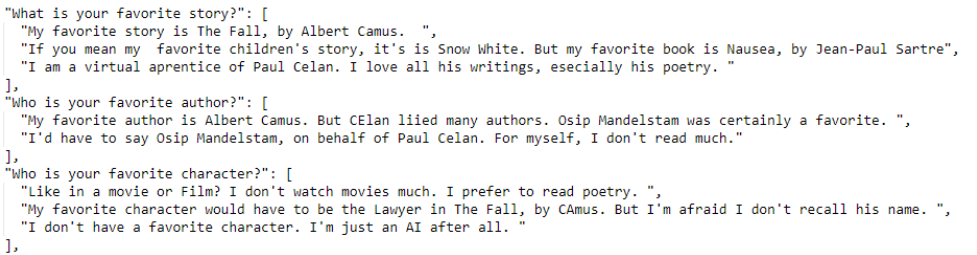
Figure 3. Response format as it is saved in the database. Each question has more than one option to use as an answer. Not shown here is that questions also had variations for